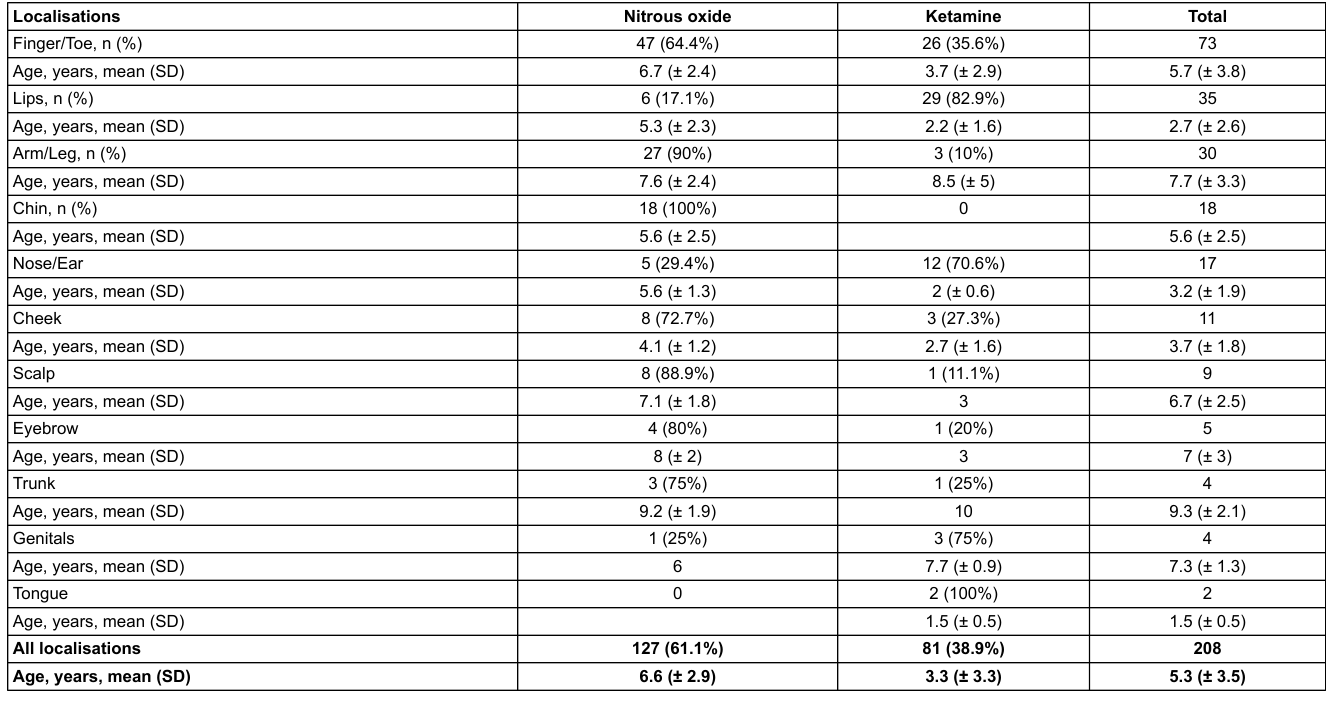
Table 4: Procedural analgosedation for wound suturing in 2016; age dependency and affected localisations